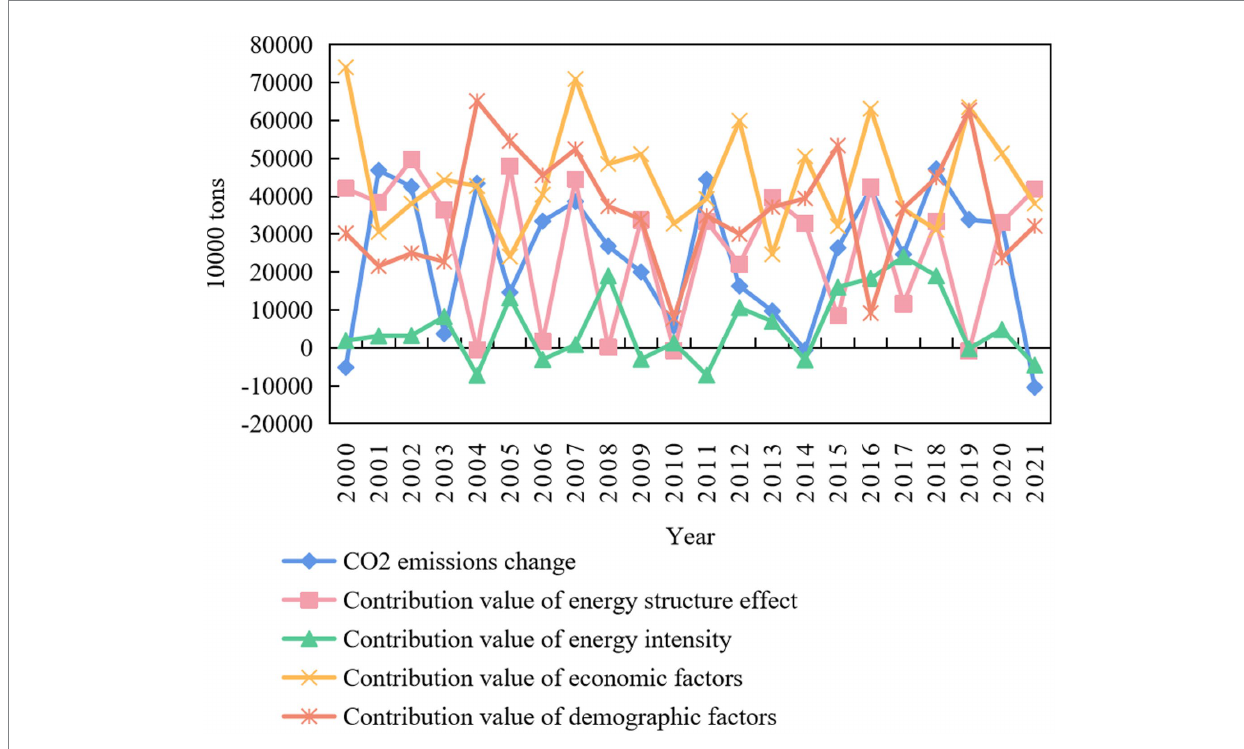
FIGURE 3 Carbon dioxide emission (CDE) driver decomposition